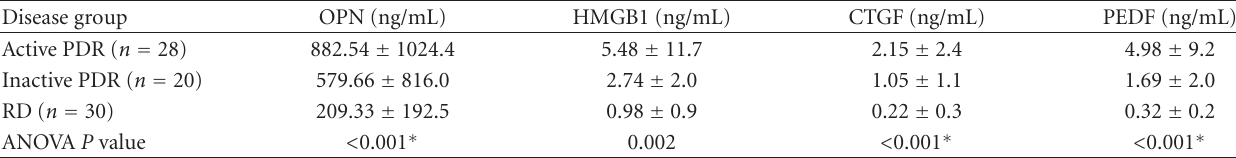
Table 2: Comparisons of mean angiogenesis and fibrogenesis regulatory factor levels in proliferative diabetic retinopathy (PDR) patients with or without active